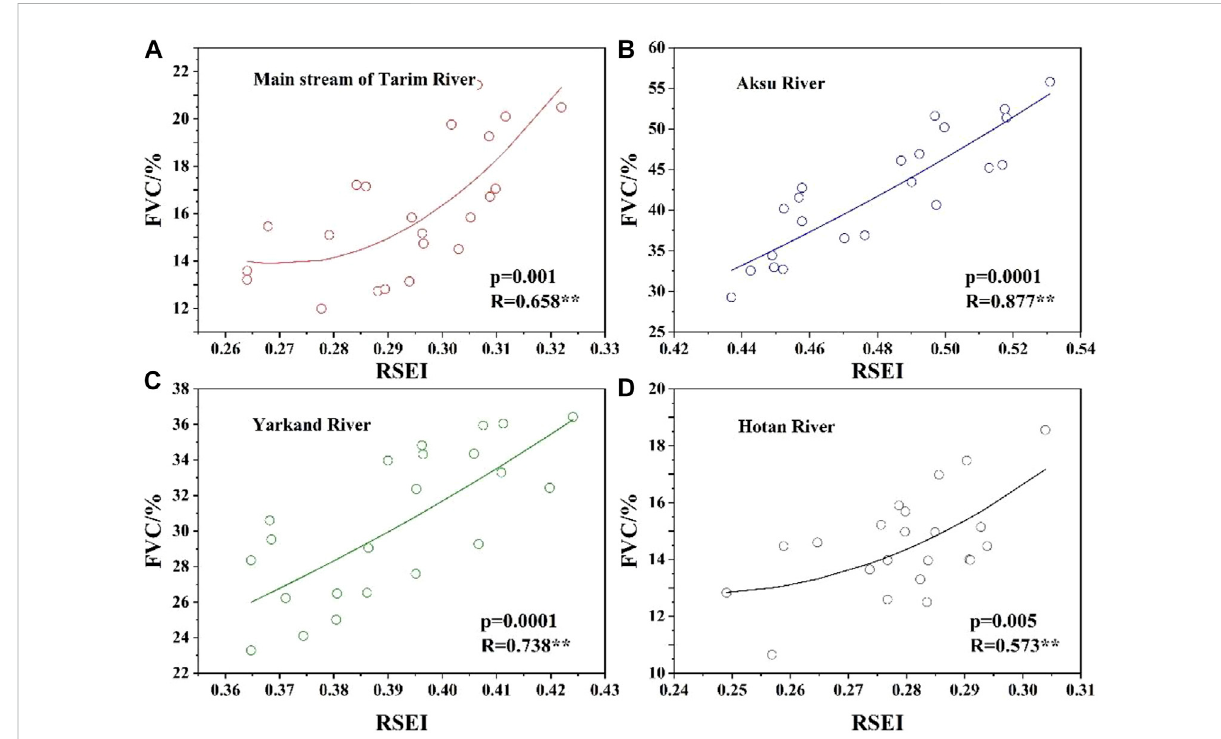
FIGURE 10 Correlation analysis of FVC and RSEI. (A) is main stream of Tarim River, (B) is Aksu River, (C) is Yarkand River, (D) is Hotan